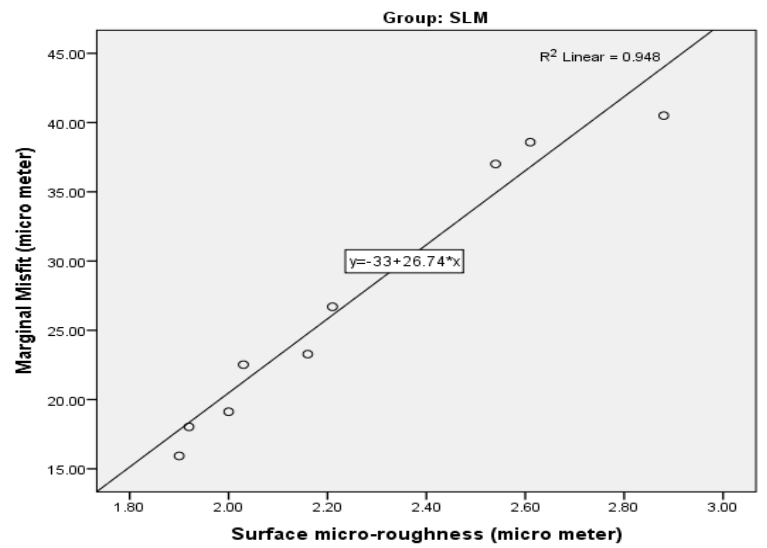
Figure 5. Showing a positive correlation between surface micro roughness and marginal misfit in CAST-LWT samples. R 2 showed 7.8% variation in marginal misfit explained by surface micro roughness; p -value 0.435, and therefore statistically insignificant.